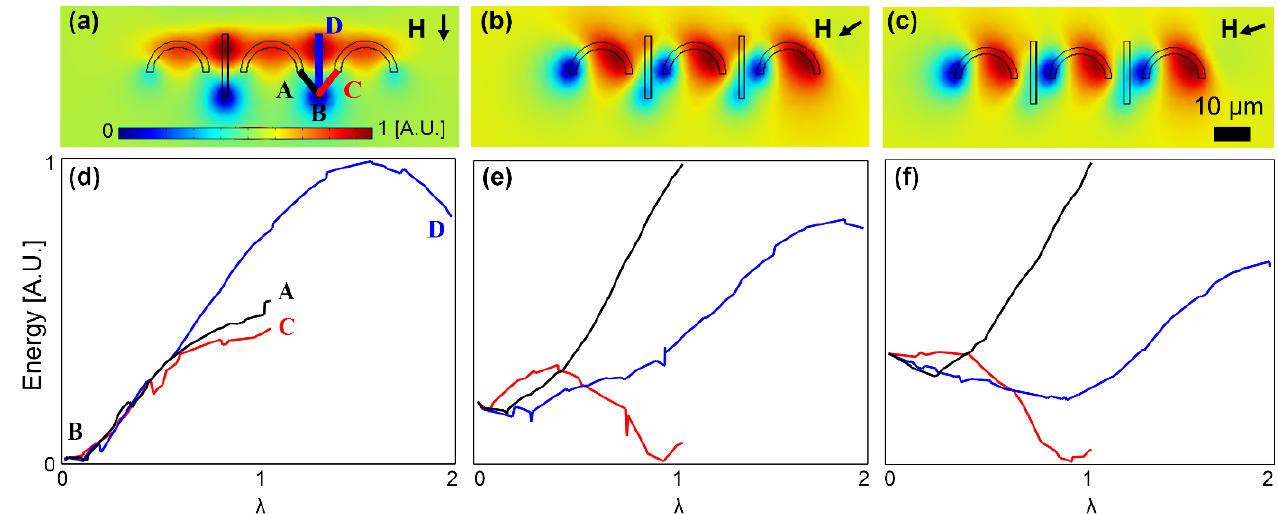
Figure 8. The particle transport failure from the I bar tip, in an unsuitable β y = − 1.52, is studied. ( a – c ) The potential energy distributions for three sequential magnetic field directions are illustrated. ( d – f ) The energies along the lines AB and BC (see ( a )) for the field directions of ( a – c ) are plotted in ( d – f ), respectively. The small black arrows stand for the magnetic field directions. The field is rotating clockwise. The energies are plotted at the center of a particle with a radius of 2.5 µm. The blue and red areas indicate the regions with low and high potential energies, respectively.